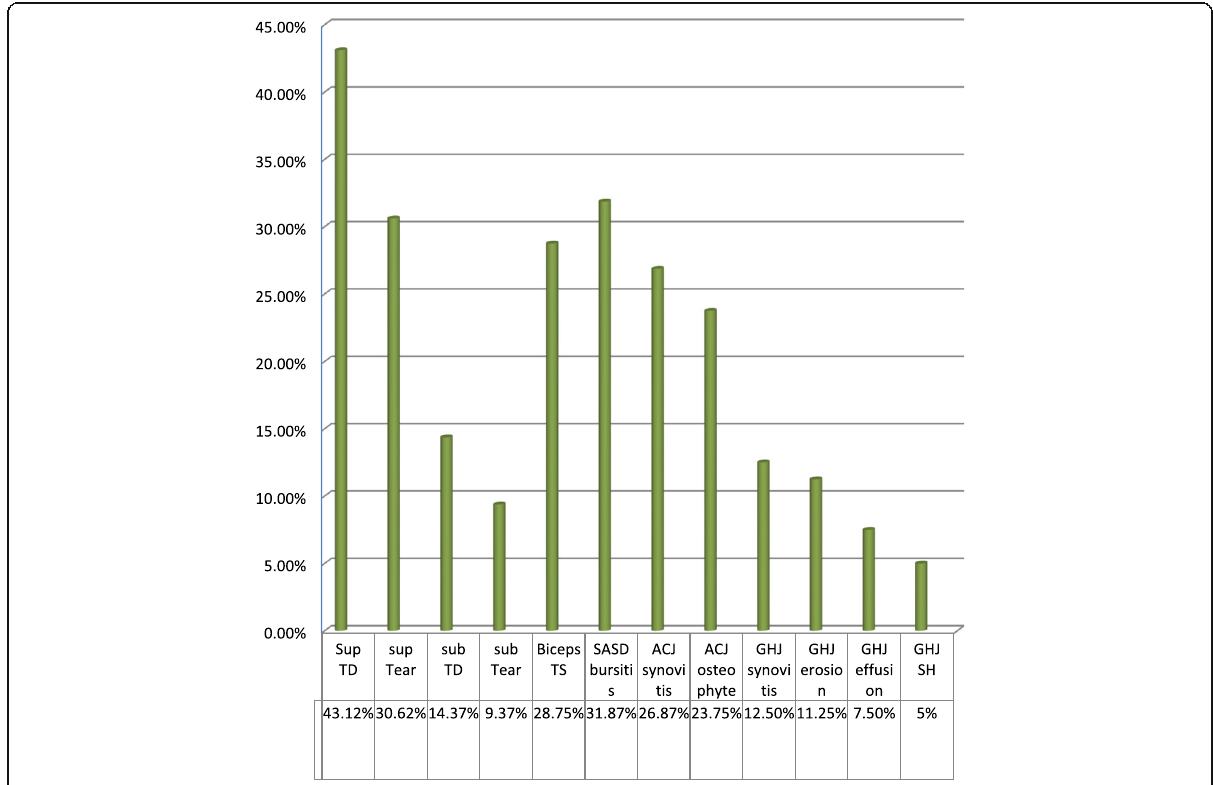
Fig. 1 Bar chart showing the peri-articular and articular subclinical ultrasonography subtype changes in RA shoulder joints. Articular lesions are ACJ synovitis, ACJ osteophyte, GHJ synovitis (GHJ, SH, and GHJ effusion), and GHJ erosion), while peri-articular lesions are Sup TD, Sup tear, Sub